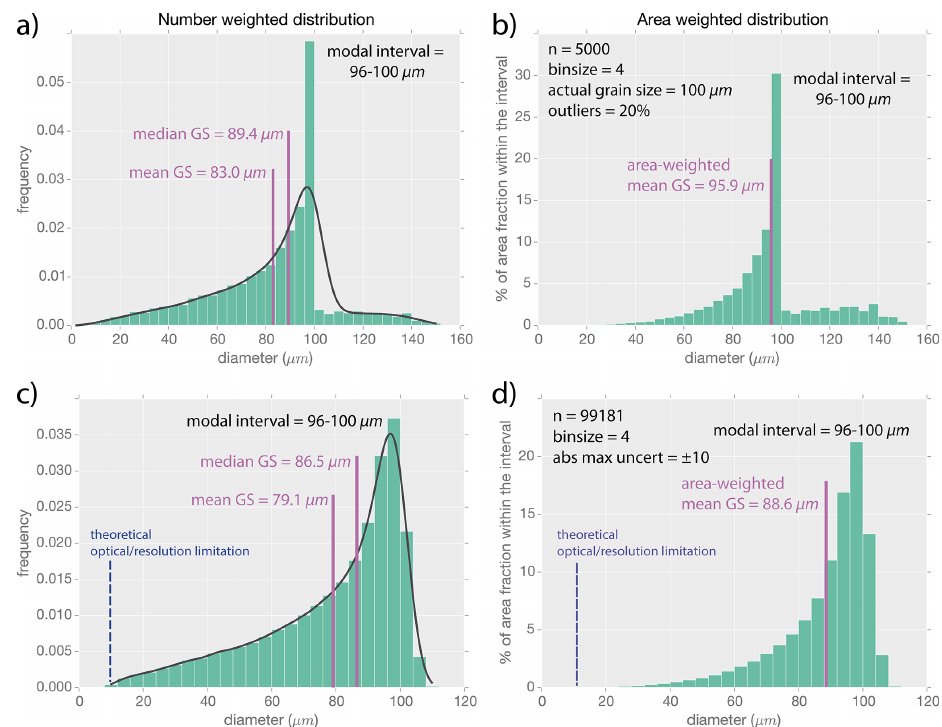
Figure 6. (a, b) Number- and area-weighted plots showing the distribution of apparent diameters of a population of spheres of size 100 in which the 20% of the data are outliers (not fully recrystallized grains; see Appendix B for details). (c, d) Number- and area-weighted plots showing the distribution of apparent diameters of a population of spheres of size 100 with uncertainty in the measure. The maximum uncer- tainty during the outline of the grains was set in ± 10 (10% the actual size). This uncertainty limit also sets a theoretical optical/resolution limitation of the measure (i.e. simulates that the technique does not allow measuring grains below the set limit). The mean, the median, the area-weighted mean and the modal interval grain sizes are